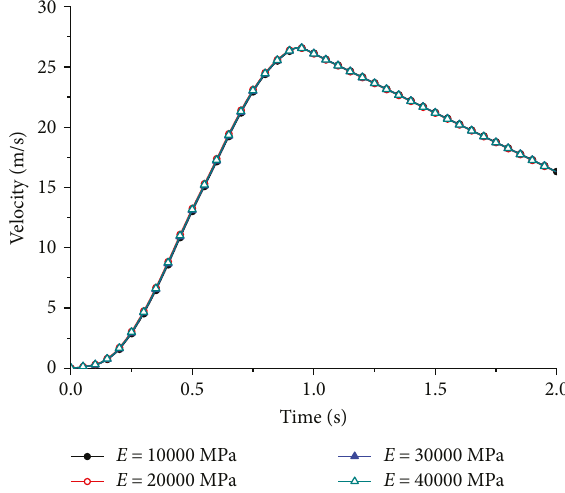
Figure 20: Longitudinal velocity of launch canister top in di ff erent surface layer thicknesses.